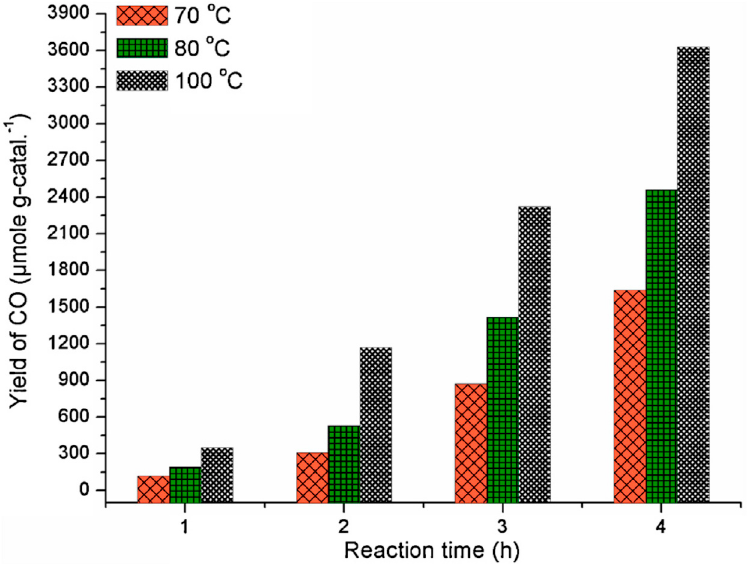
Figure 9. Temperature dependent production of CO, reproduced with permission from reference [6].